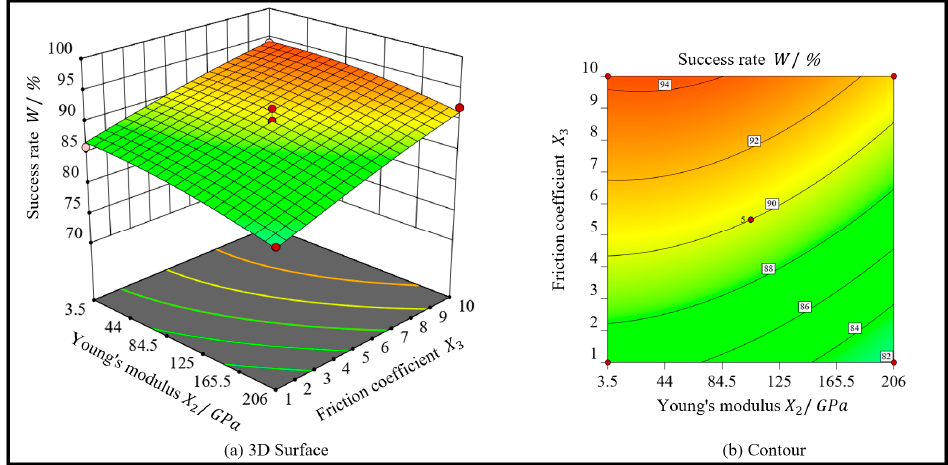
Figure 14. Effects of Young’s modulus and friction coefficient on success rate of sweet cherries.